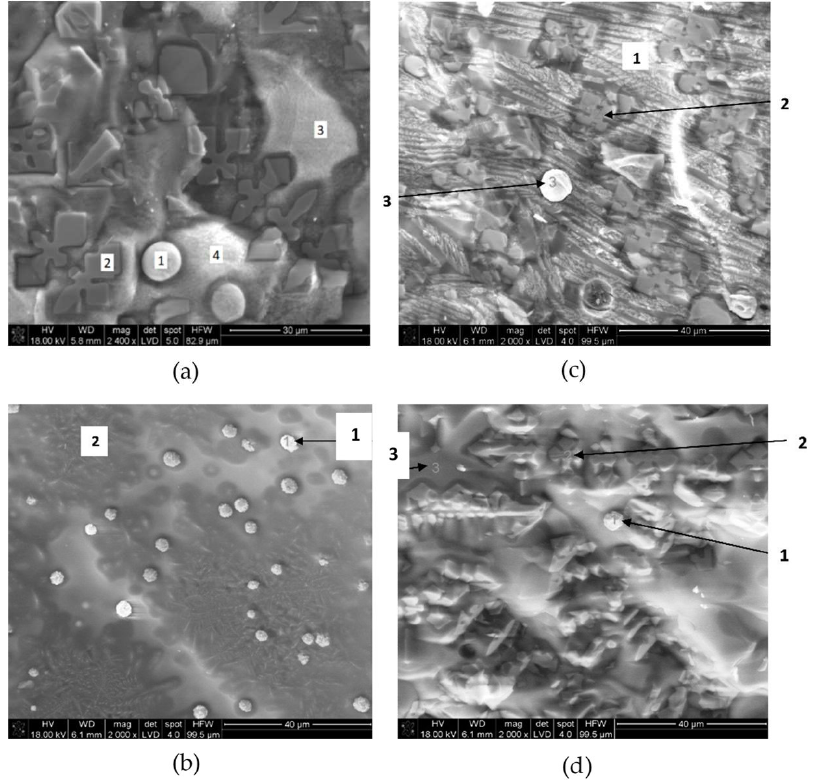
Figure 4. ( a ) SEM-EDX sample identified as CusinBonus; ( b ) SEM-EDX sample identified as CuCon3; ( c ) SEM-EDX sample identified as CuCon1; ( d ) SEM-EDX sample identified as CuSin1.